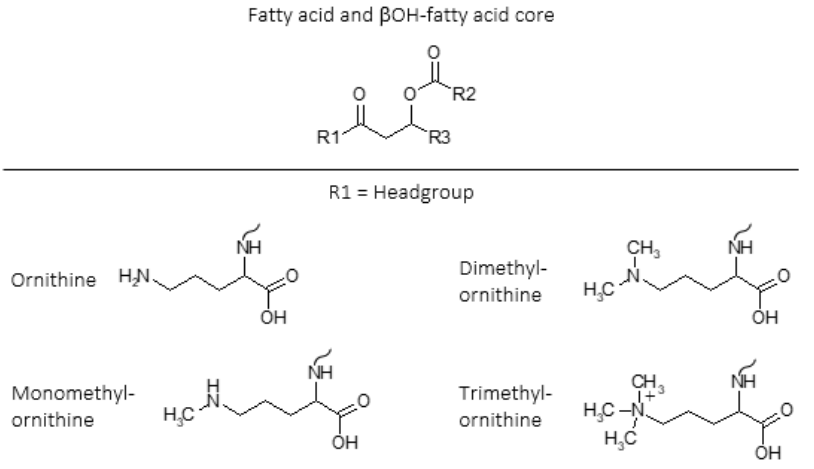
Figure 1. Intact polar lipid (IPL) structures of ornithine (OL), monomethylornithine (MMO), dimethylornithine (DMO), and trimethylornithine (TMO) lipids including fatty acid and β OH-fatty acid core lipids. R1 = headgroup; R2, R3 = alkane/alkene chains. Ornithine (OL; [13–15]); monomethylornithine (MMO; [16]); dimethylornithine (DMO; [16]); trimethylornithine (TMO; [16]). Figure adapted from [17].